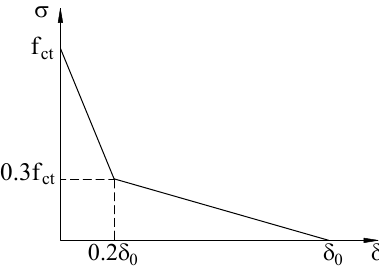
Figure 6. Concrete softening curve under uniaxial tension.